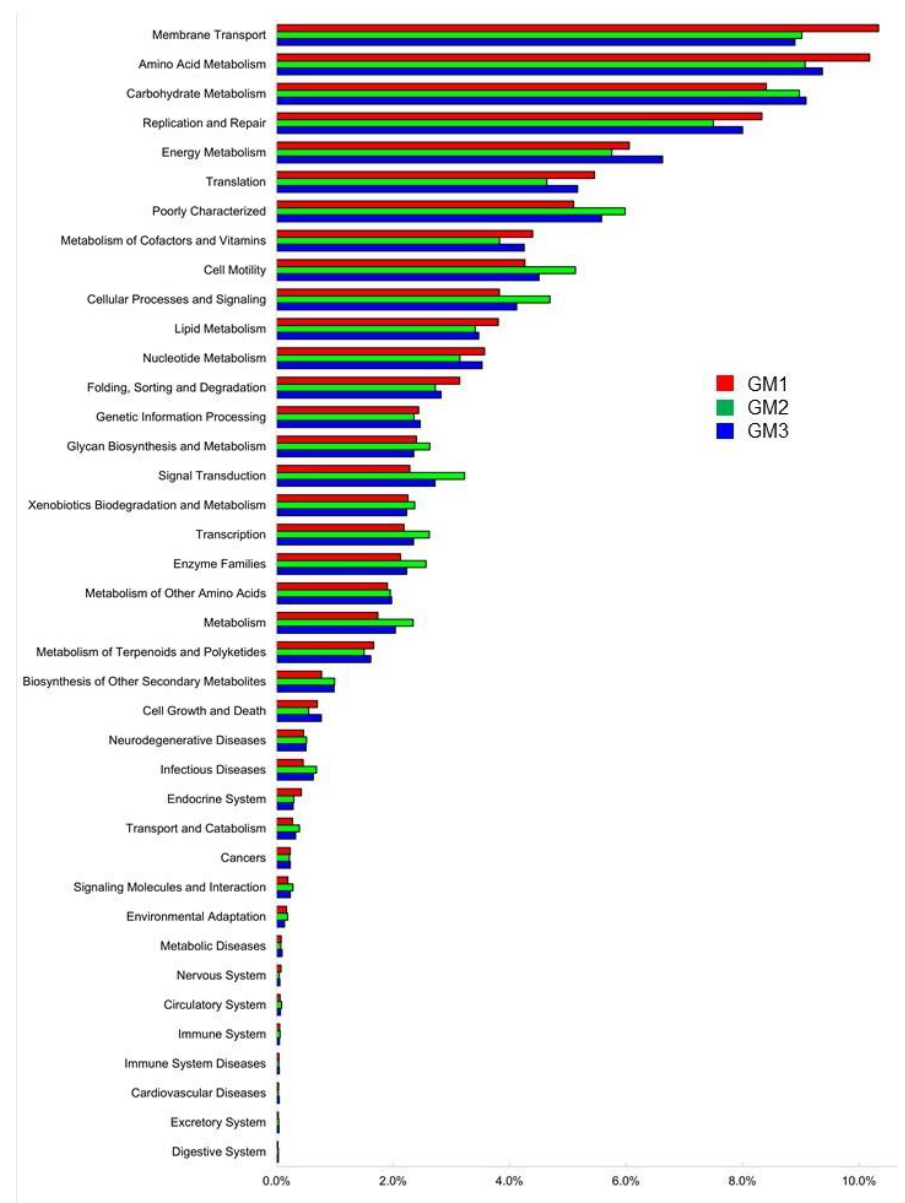
Figure 11. KEGG Level 2 metabolic pathways of GM1 (red), GM2 (green), and GM3 (blue) speleothem microbiomes. Pathway categories are shown in the order of relative abundances in GM1.